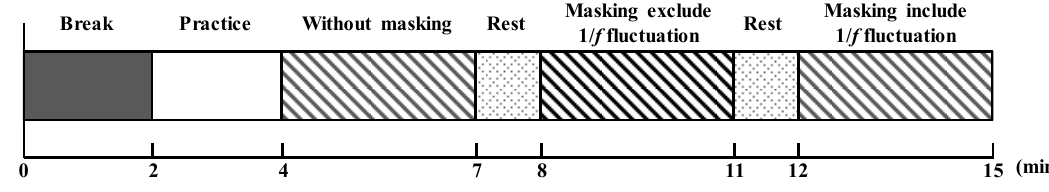
Figure 6. The experimental flow about the relaxation effect by the music including a 1/ f fluctuation.